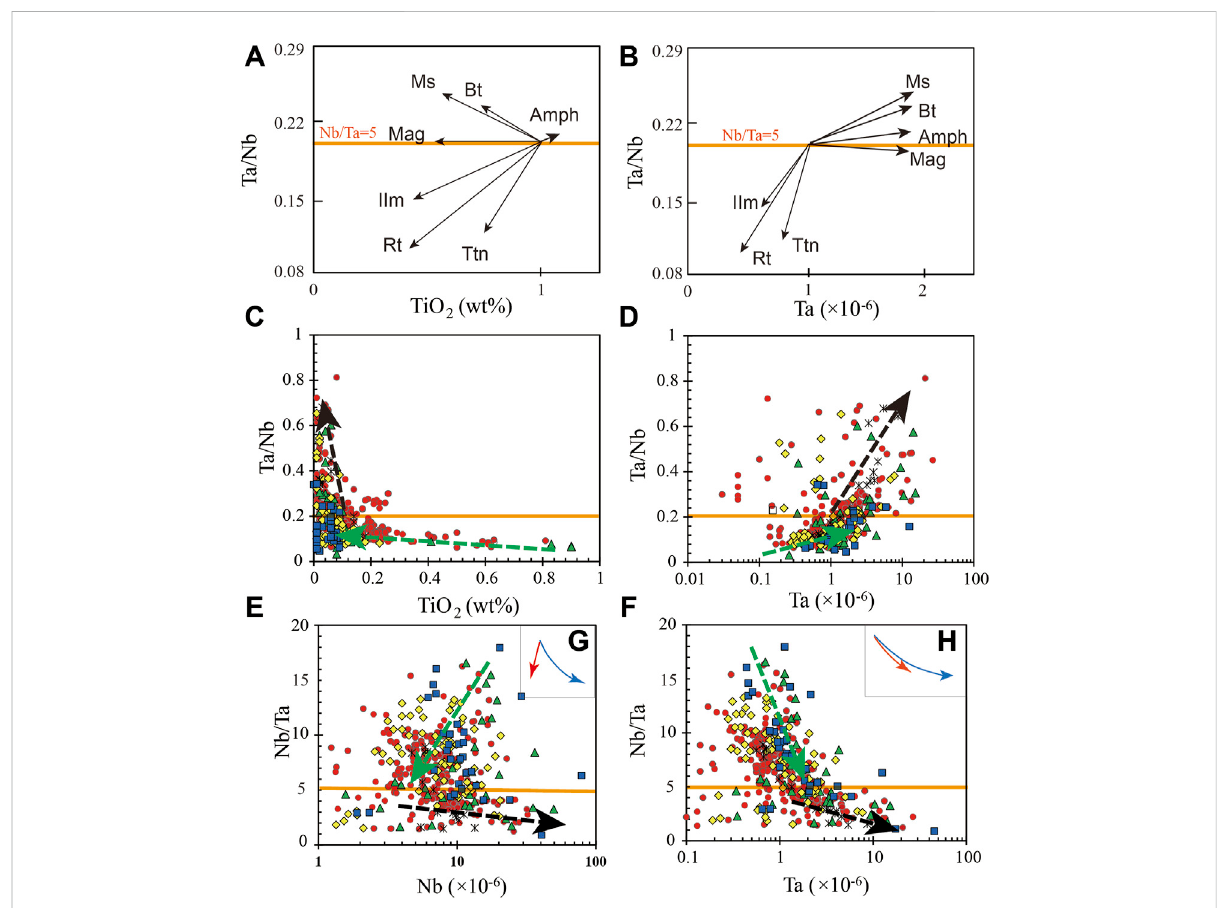
FIGURE 7 Nb and Ta compositional evolution in granites with fractionation of the Ti-bearing oxides (rutile, titanite, and ilmenite) and mica (biotite and muscovite). (A,B) are models from Stepanov et al. (2014); (G,H) are models from Ballourd et al. (2016). Black arrow represents fractionation of micas whichproducesincreaseinTaandNbcontentsandTa/Nb.GreenarrowrepresentsfractionationofassemblagemadeofTi-bearingoxidesandmica which produces a decrease in Nb contents but a slightly increase in Ta contents and